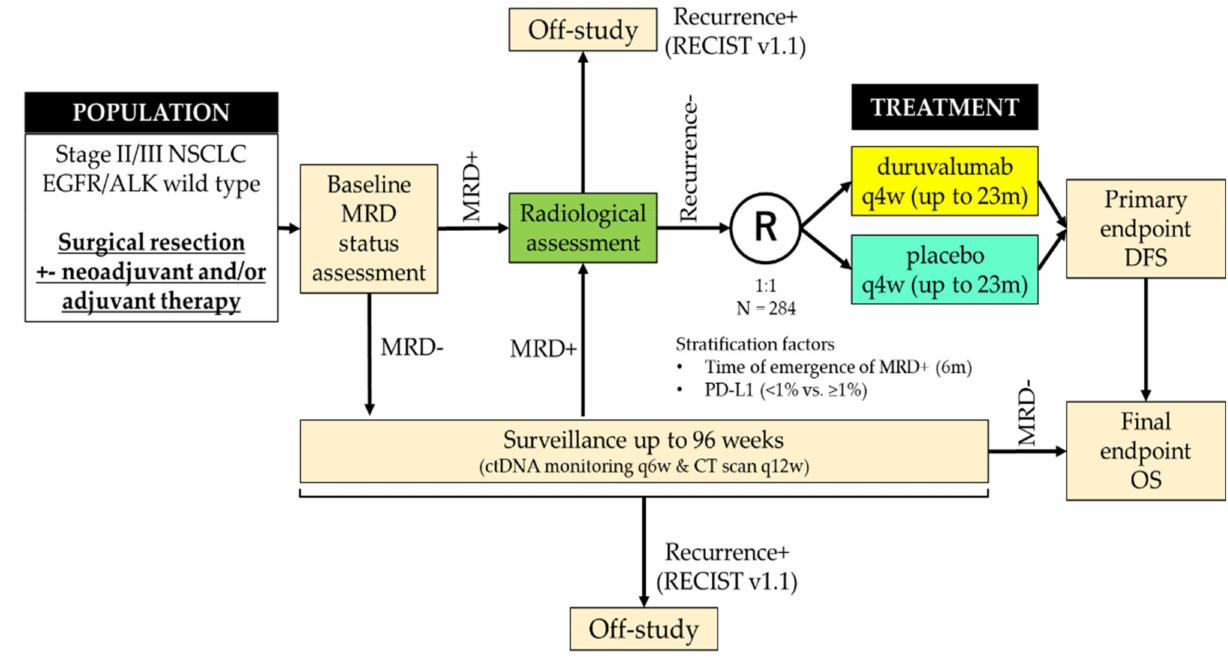
Figure 2. Study design of the MeRmaiD-2 trial (modified from the presentation of Spigel et al. [49]). The MeRmaiD-2 trial (NCT04642469) enrolled patients with stage II–III NSCLC after complete resection plus optional neoadjuvant and/or adjuvant therapy. Eligible patients in whom the presence of MRD was confirmed by regular monitoring for minimal residual disease (MRD) emergence via circulating tumor DNA (ctDNA) analysis during the surveillance period were randomised to receive durvalumab or